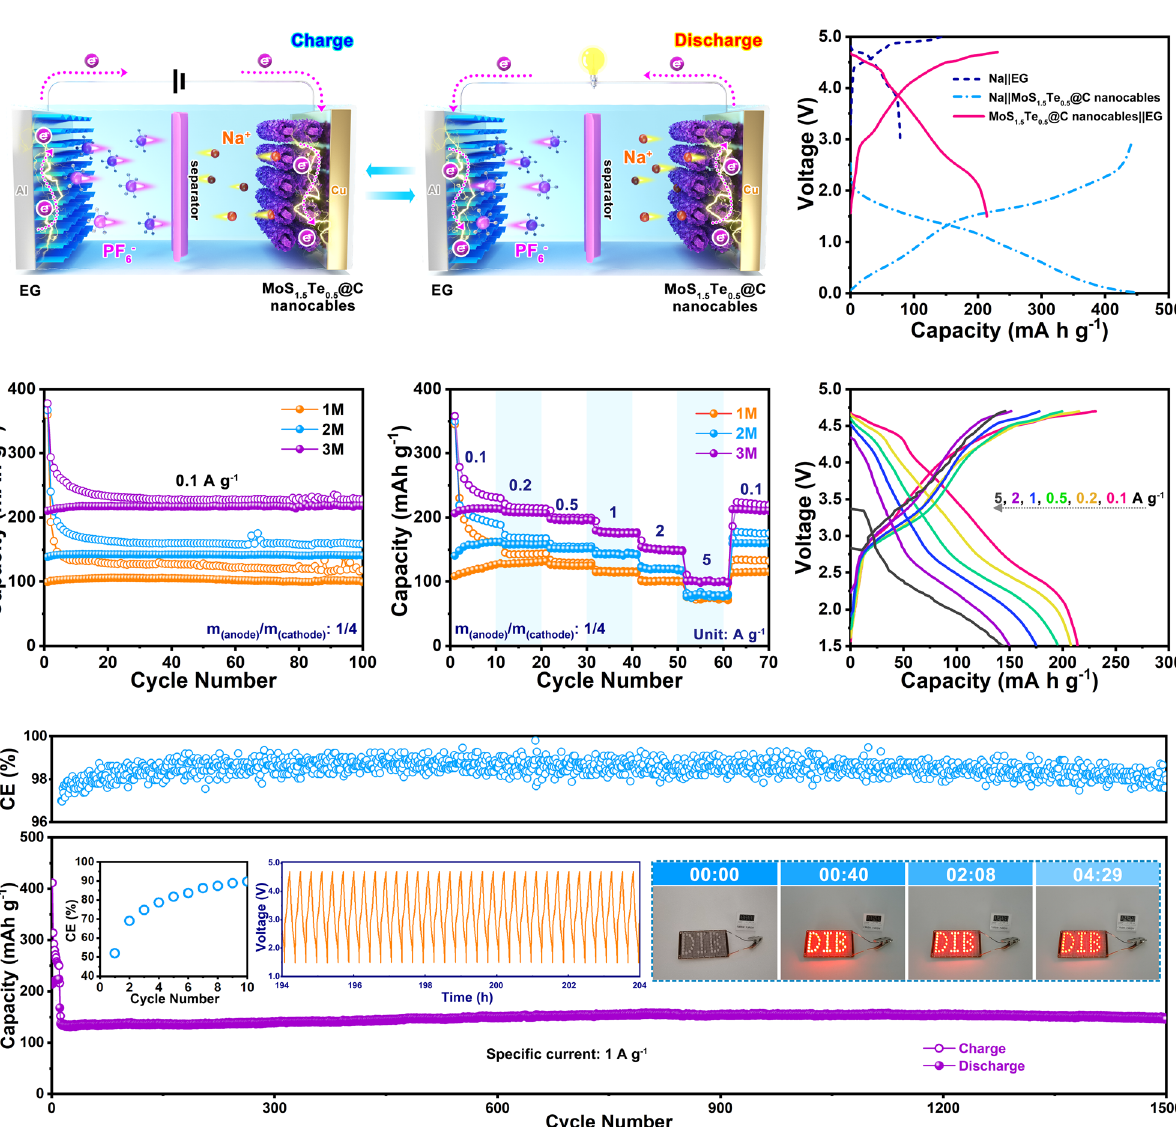
Fig. 4 Electrochemical energy storage performance of the MoS 1.5 Te 0.5 @C nanocables||EG dual-ion cells. a Schematic illustration of the MoS 1.5 Te 0.5 @C nanocables||EG dual-ion cell, b potential pro fi les for the Na metal||EG, Na metal||MoS 1.5 Te 0.5 @C nanocables and MoS 1.5 Te 0.5 @C nanocables||EG cells in 3 M NaPF 6 in EC/EMC/DMC (1:1:1, by volume) electrolyte solution at 25 °C. c Cycling stability at 0.1 A g − 1 and d rate performance pro fi les at various rates (from 0.1 to 5 A g − 1 ) for SDIBs with different NaPF 6 salt concentration (i.e., 1.0, 2.0, and 3.0 M) in EC/EMC/DMC (1:1:1, by volume). e Charging- discharging curves in a 3 M NaPF 6 in EC/EMC/DMC (1:1:1, by volume) electrolyte solution at 25 °C, and f long-term cycling stability of MoS 1.5 Te 0.5 @C nanocables||EG dual-ion cell at 1 A g − 1 in a 3 M NaPF 6 in EC/EMC/DMC (1:1:1, by volume) electrolyte solution at 25 °C. Inset in ( f ) the coulombic ef fi ciency (CE) of initial 10 cycles (left), the corresponding charge-discharge curves at 1 A g − 1 from 192 to 206 h (middle) and the digital photographs of the “ DIB ” logo composing of 42 LEDs light up by one single cell